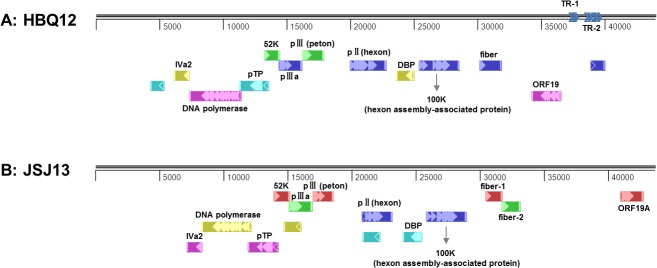
Schematic representation of HBQ12 and JSJ13 genomes, members of the genus Aviadenovirus.